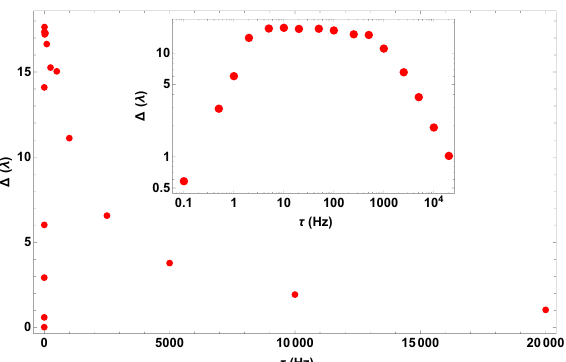
Figure 3. Enantiomeric separation versus τ . The inset figure shows enantiomeric separation versus τ in the logarithmic scale.